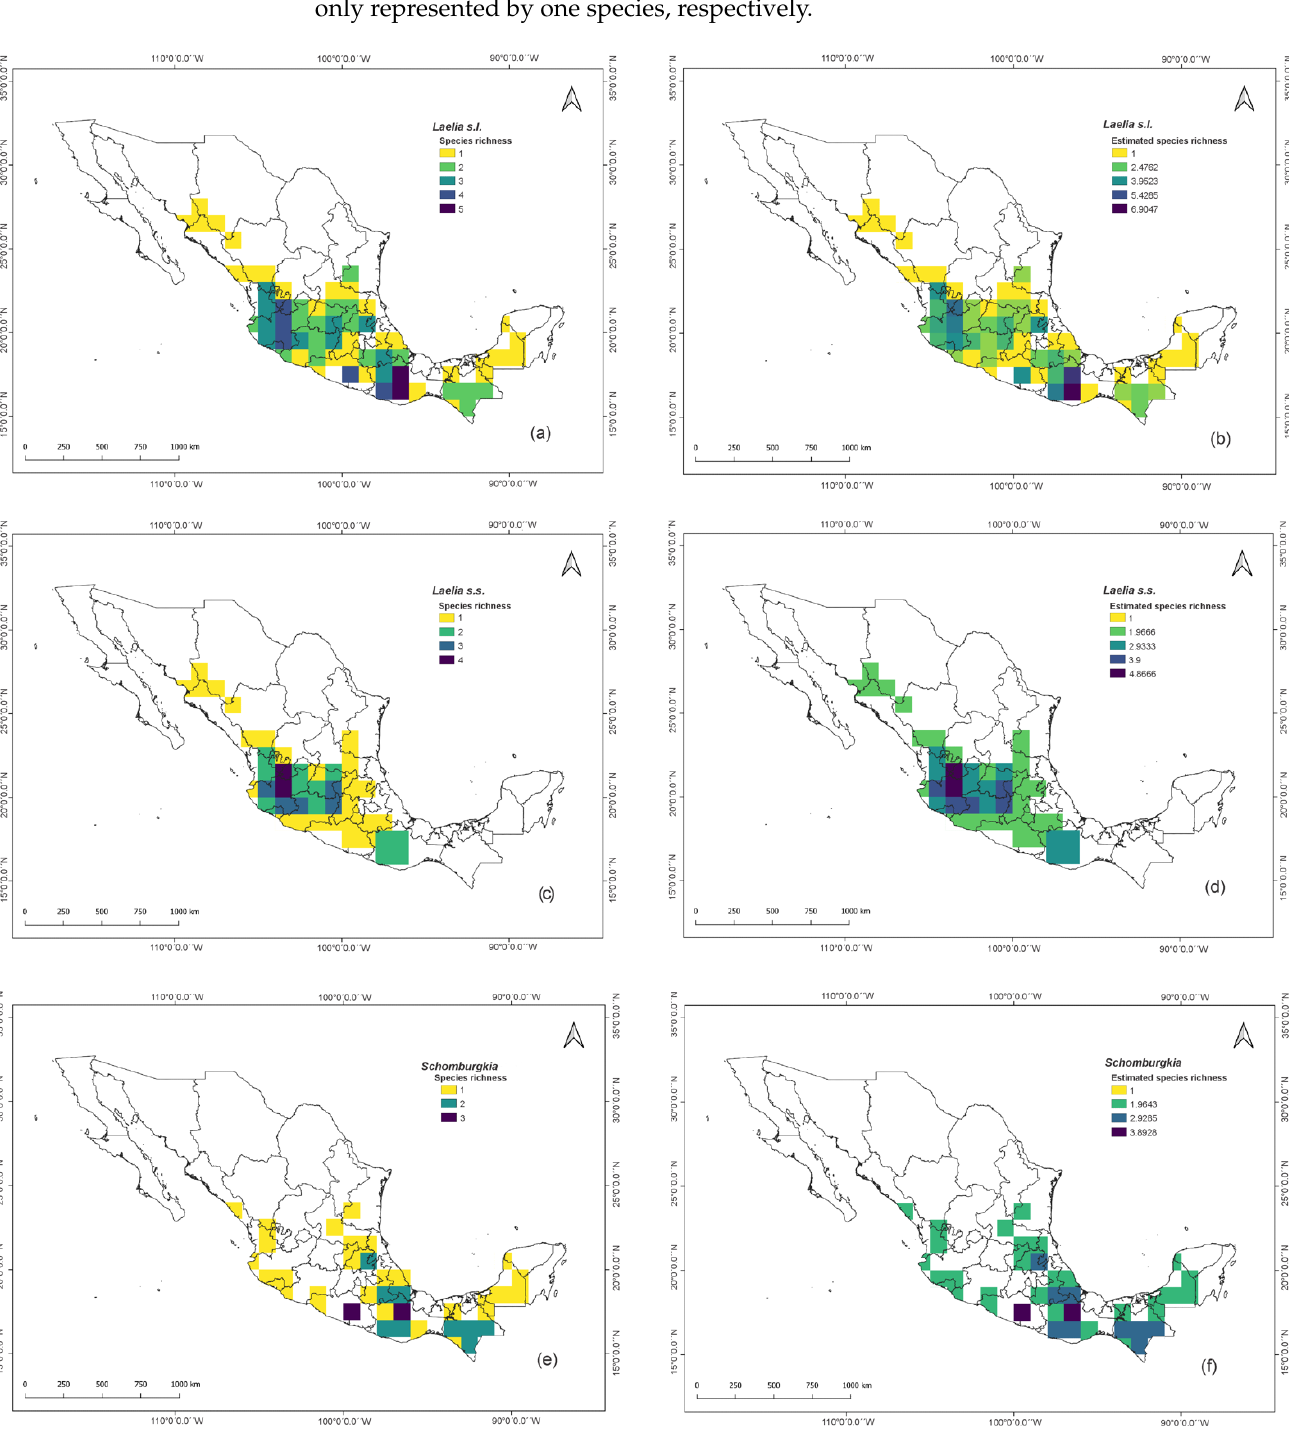
Figure 1. Species richness in Mexico for Laelia s.l.: ( a ) absolute richness; ( b ) estimated richness. Species richness in Mexico for Laelia s.s.: ( c ) absolute richness; ( d ) estimated richness. Species richness in Mexico for Schomburkgia : ( e ) absolute richness; ( f ) estimated richness.